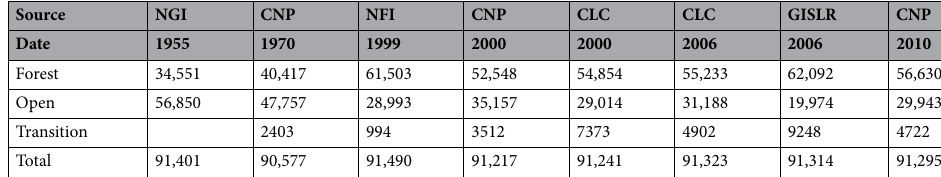
Table 1. Time course of area of three major land cover types in the central protected zone of the Cévennes National Park. The sources are: NGI National Geographic Institute, CNP Cévennes National Park, NFI National Forest Inventory, CLC Corine Land Cover, GISLR Languedoc-Roussillon region.